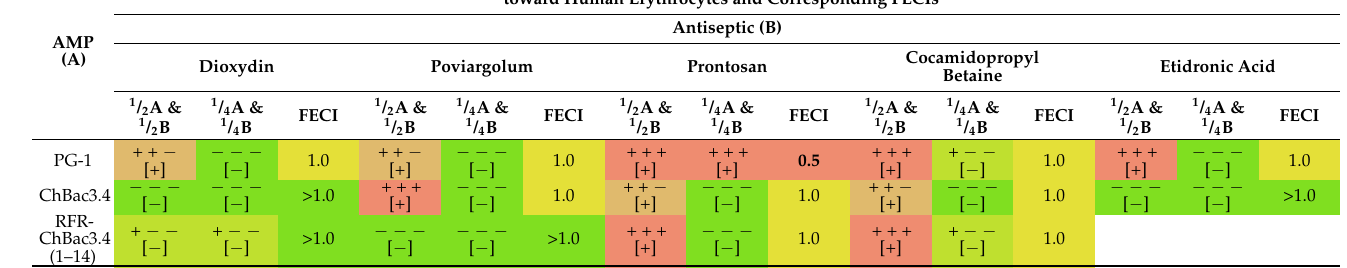
Table 5. Hemolytic effect of combinations of AMPs with antiseptics and surfactants toward human